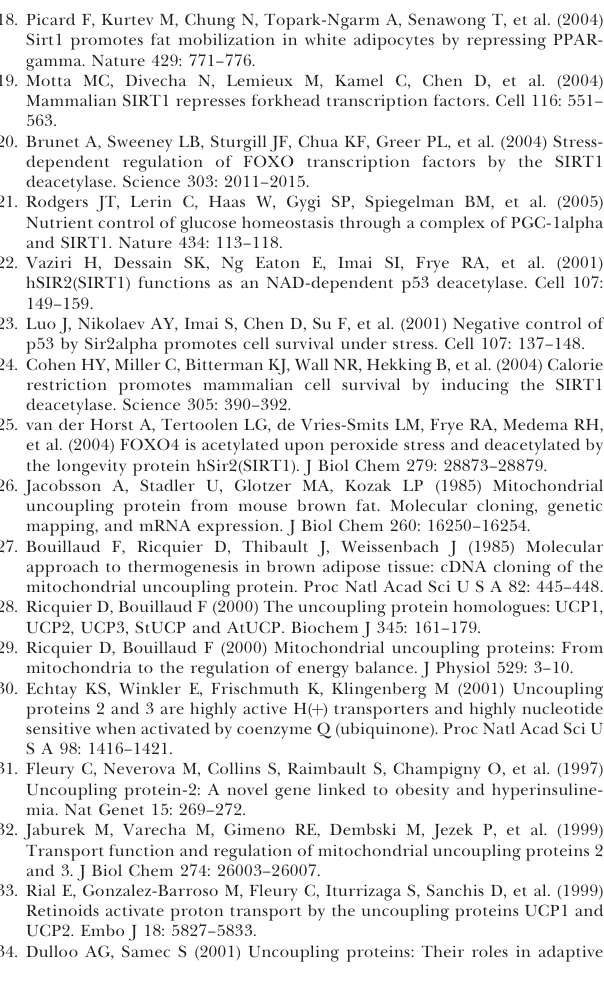
Figure S1. Growth Curve Plot of Cell Number vs. Time of INS-1 Cells Transfected with pSUPER (black line) or SiRNA Sirt1 (red line) Found at DOI: 10.1371/journal.pbio.0040031.sg001 (163 KB